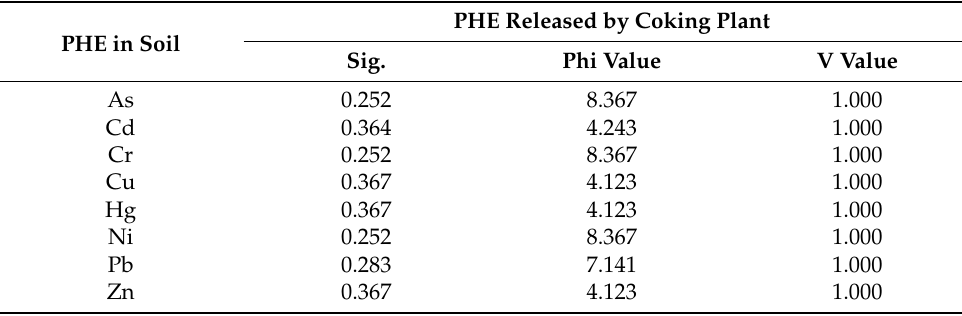
Table 2. Crosstabs analysis between PHEs discharged by coking and air quality. PHE Released by Coking PHE in Soil